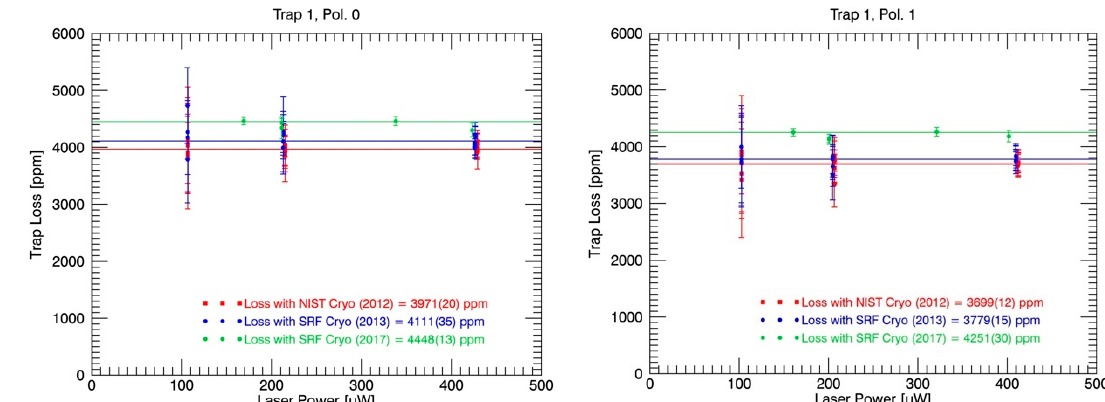
Figure 4. Power transfer calibrations of two NIST Si trap detectors to both the SRF L-1 CR as well as an original NIST secondary standard CR during the initial LASP SRF development. These measurements bracket the full 5-year campaign of the TSIS-1 SIM calibrations.